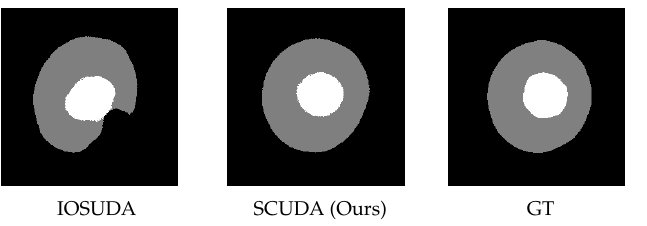
Figure 1. Comparison of the segmentation results between the state-of-the-art method IOSUDA [16] and our SCUDA method on a fundus image. The abbreviation GT refers to ground